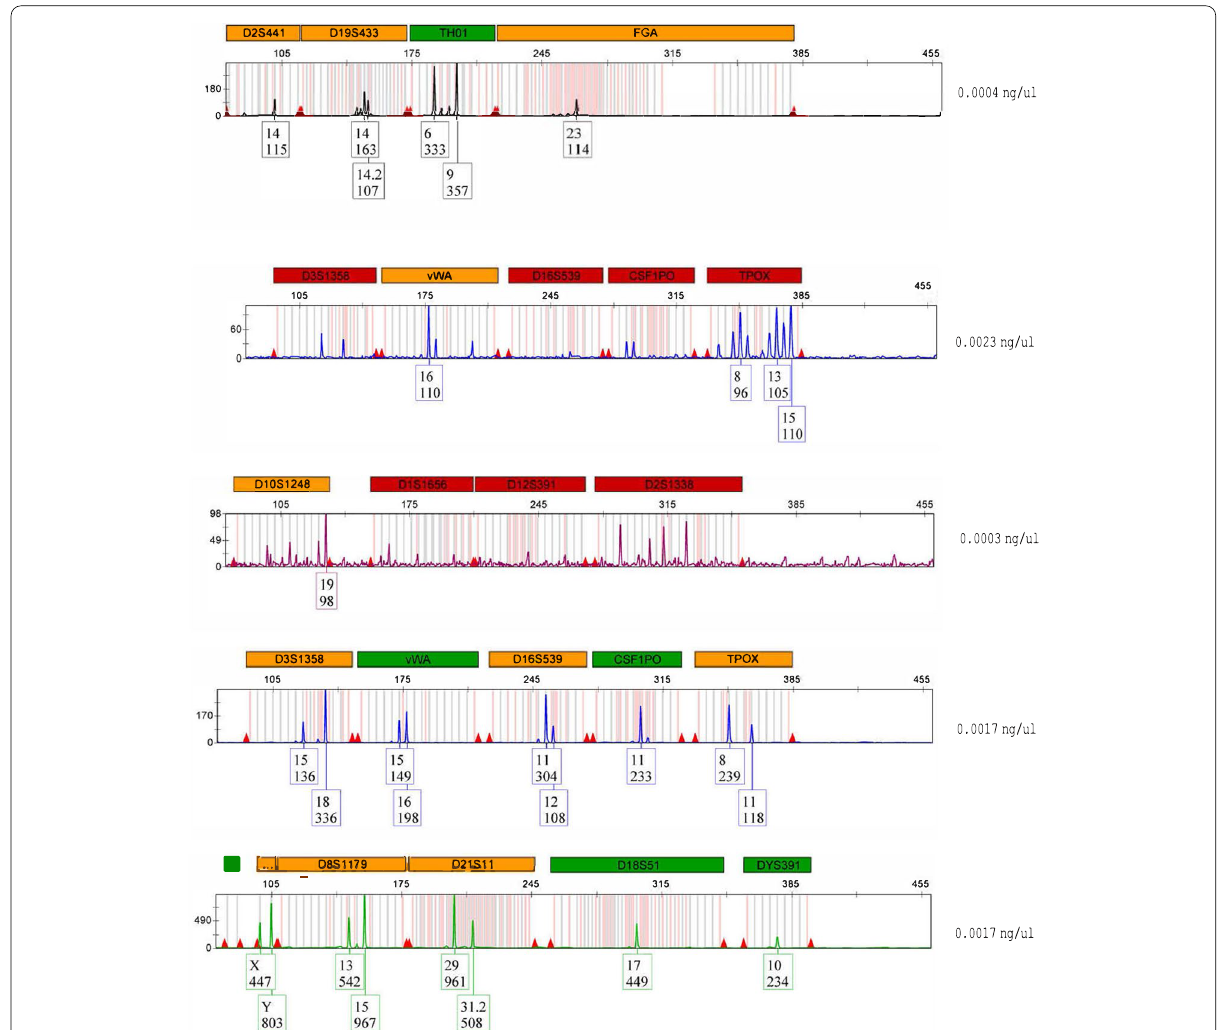
Fig. 1 STR profiles generated from post‑sterilization with different concentrations of